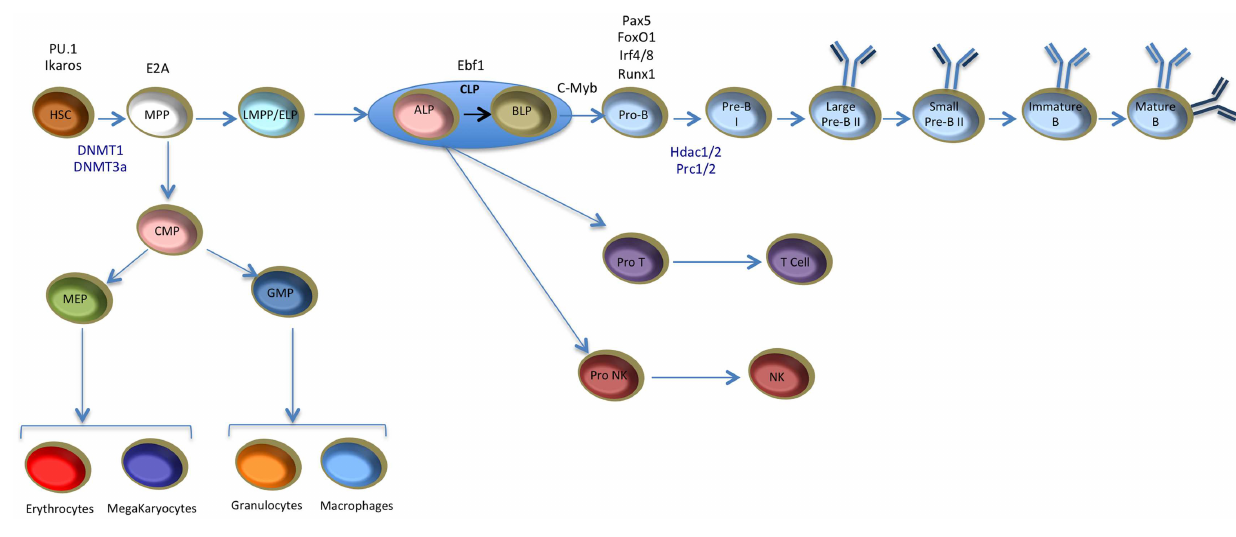
FIGURE 2 | Scheme for B cell development from HSCs to mature B cells. Successive stages and alternative lineages are indicated. Key transcription factors and chromatin regulators are shown according to their established requirement during the early B cell differentiation process. HSC, hematopoietic stem cell; MPP, multipotent progenitors; MEP, megakaryocyte–erythrocyte progenitors; LMPP, lymphoid-primed multipotent progenitors; ELP, early lymphoid progenitors; CMP, common myeloid progenitors, GMP, granulocyte–macrophage progenitors; CLP,